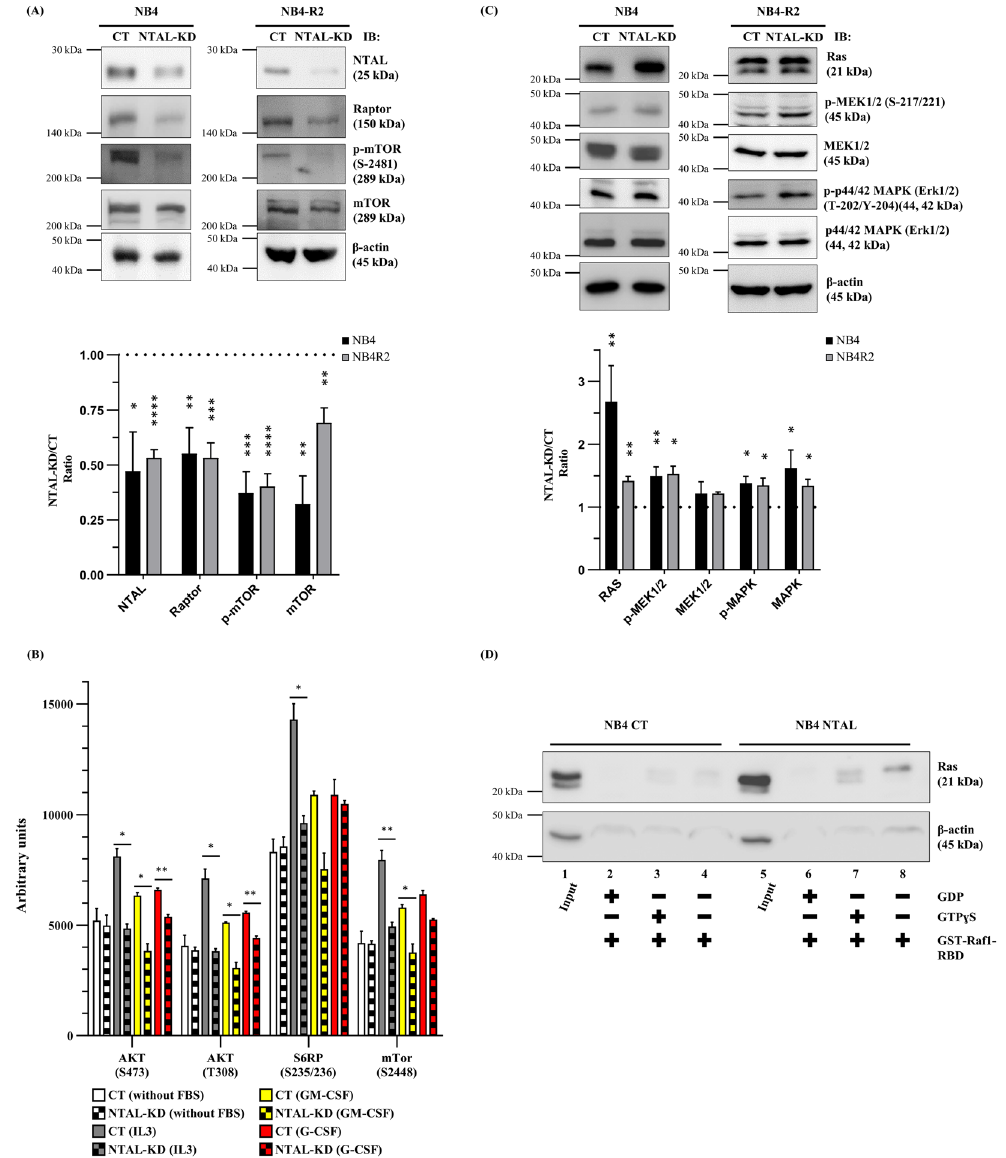
Figure 2. Non-T cell activation linker-knockdown (NTAL-KD) modulates the Akt/mTOR and Ras/MAPK pathways. ( A ) Western blotting analyses of the NTAL-knockdown effect in NB4 and NB4-R2 cells on proteins participating on the mTOR pathway. Bar graphs represent the NTAL-KD to control (CT) ratio. Values are show as the mean ± SEM. ( B ) Effect of NTAL protein on the activation of the Akt pathway after addition of myeloid growth factors (MGF). NB4 cells (CT or NTAL-KD) were cultured for 16–18 h in the absence of FBS, whereupon MGF (hr- IL-3 or hr-GM-CSF or hr-G-CSF or hr-SCF) was added. Aliquots were withdrawn after 15 min of each treatment and evaluated with the PathScan Intracellular Signaling Array Kit. Values were obtained using the combined signal of four individual spots. Values are show as the mean ± SEM. ( C ) Western blotting analyses of NTAL-knockdown effect in NB4 and NB4-R2 cells on proteins participating on MAPK pathway. NB4 and NB4-R2 cell lines were independently analyzed, CT vs. NTAL-KD. Bar graphs show the NTAL-KD to CT ratio. Values are shown as the mean ± SEM. ( D ) NB4 cells (CT or NTAL-KD) were treated with GTP γ S (final concentration of 0.1 mM), or GDP (final concentration of 1 mM) to activate or inactivate RAS, respectively (Active Ras assay, Cell Signaling Technology Kit #8821). Cell lysates (500 µ g) were incubated with GST-Raf1-RBD resin to pool-down active Ras. Western blotting of the pull-down eluted samples (lanes 2, 3, and 4 or 6, 7 and 8) was performed using a Ras mouse mAb. Cell lysate (20 µ g, lane 1 or 5) was used as input control. Values are show as the mean ± SEM ( * P < 0.05; ** P < 0.01; *** P < 0.001; **** P < 0.0001). NB4 and NB4-R2 cell lines were independently analyzed, CT vs.